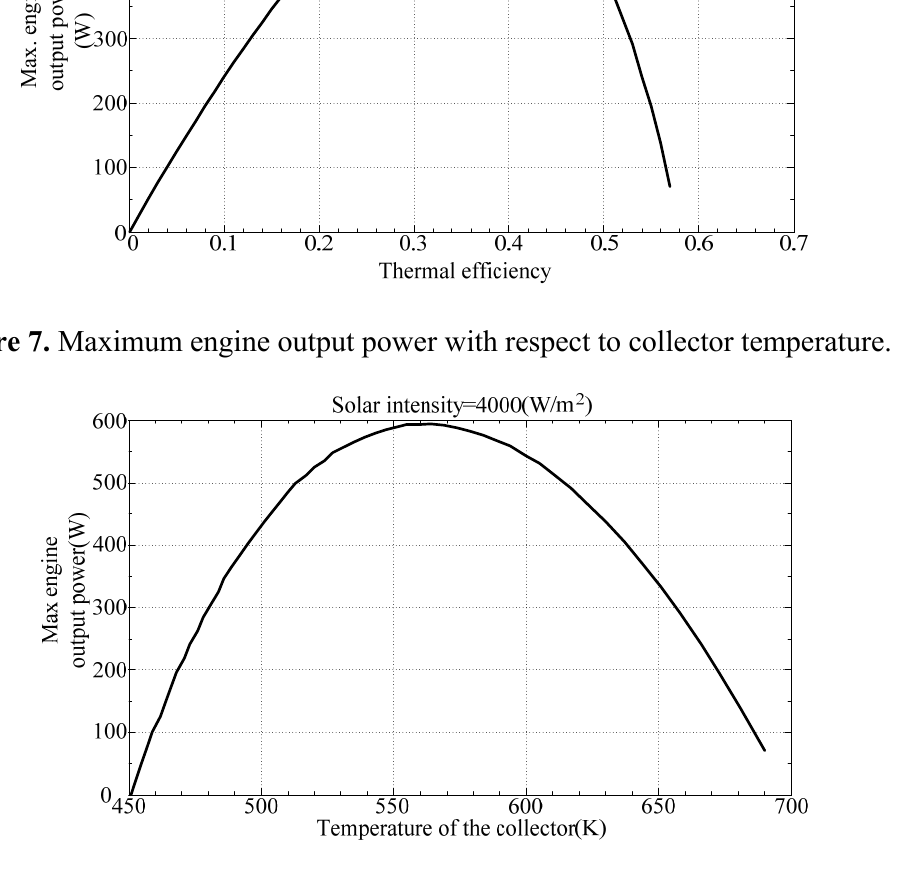
Table 2. System parameters for maximum output